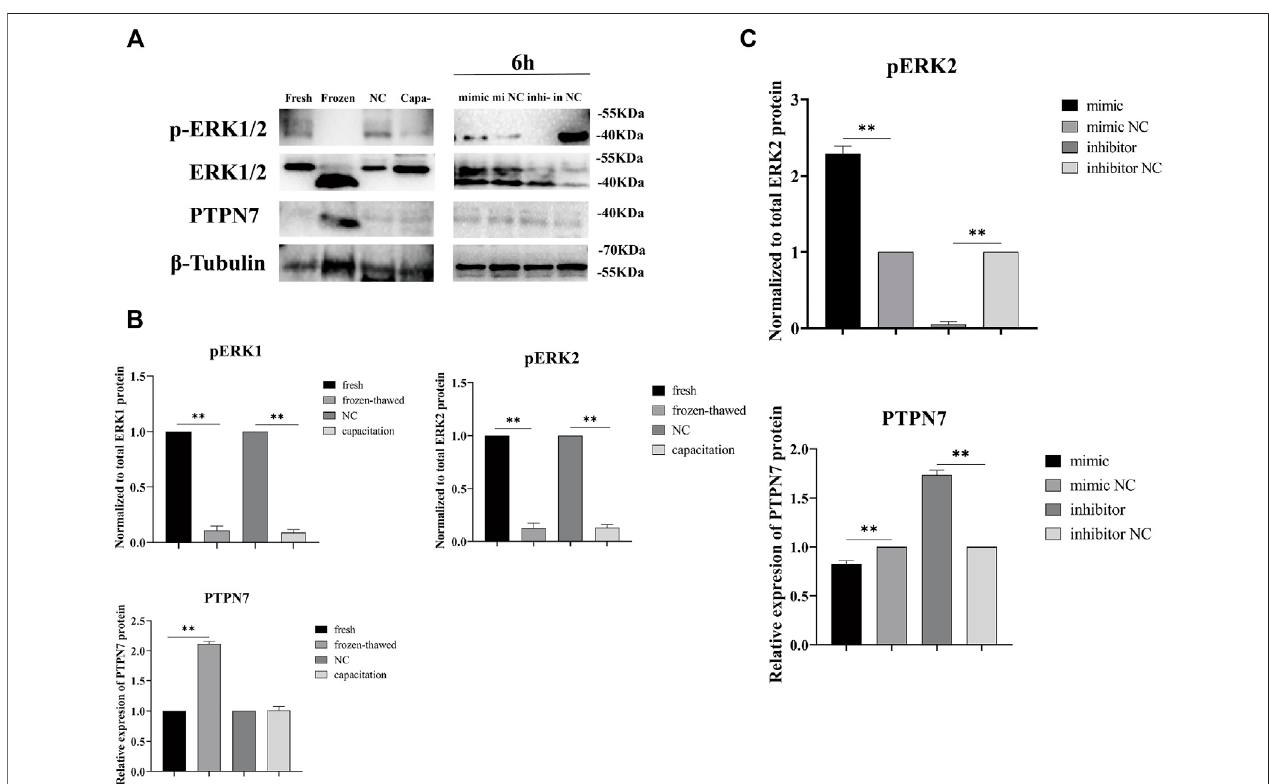
FIGURE 7 | The protein levels of PTPN7, total ERK1/2, and phosphorylated ERK1/2 in boar sperm were measured by Western blot. (A) Anti-phosphorylated proteins were extracted from transfected, frozen – thawed, and capacitated sperm. Western blots performed using anti-ERK1/2, phospho-ERK1/2, PTPN7, and β - Tubulin antibodies. The results are representative of three independent experiments. (B) The protein levels of phosphorylated ERK1/2 and PTPN7 in fresh, frozen – thawed, NC, and capacitated sperm. “ NC ” means negative control group incubated at 37 ° C. “ Capa- ” means capacitation group. The protein level of phosphorylated ERK1/2 was quanti fi ed by normalization to total ERK1/2 protein using ImageJ, and the level of PTPN7 was quanti fi ed by normalization to β -Tubulin. (C) The protein levels of phosphorylated ERK2 and PTPN7 were shown in transfected sperm at 6